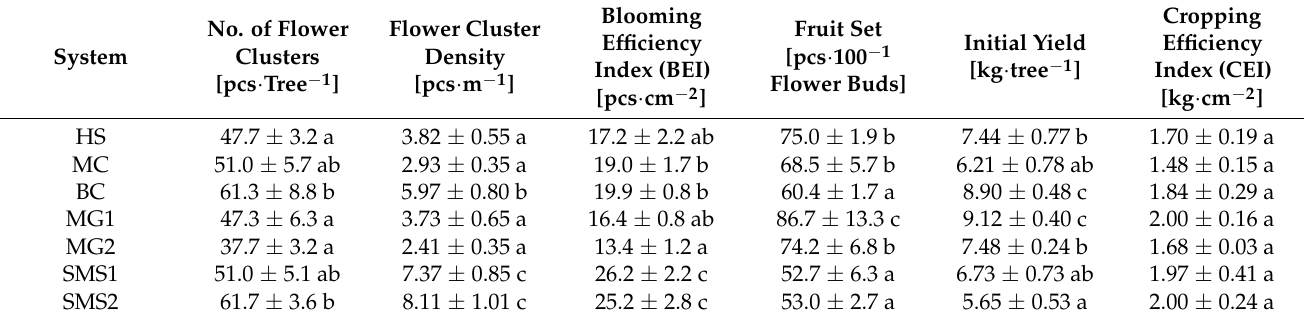
Table 6. The blooming intensity, fruit set, and initial bearing of the tested apple trees depended on the floor management system used during the